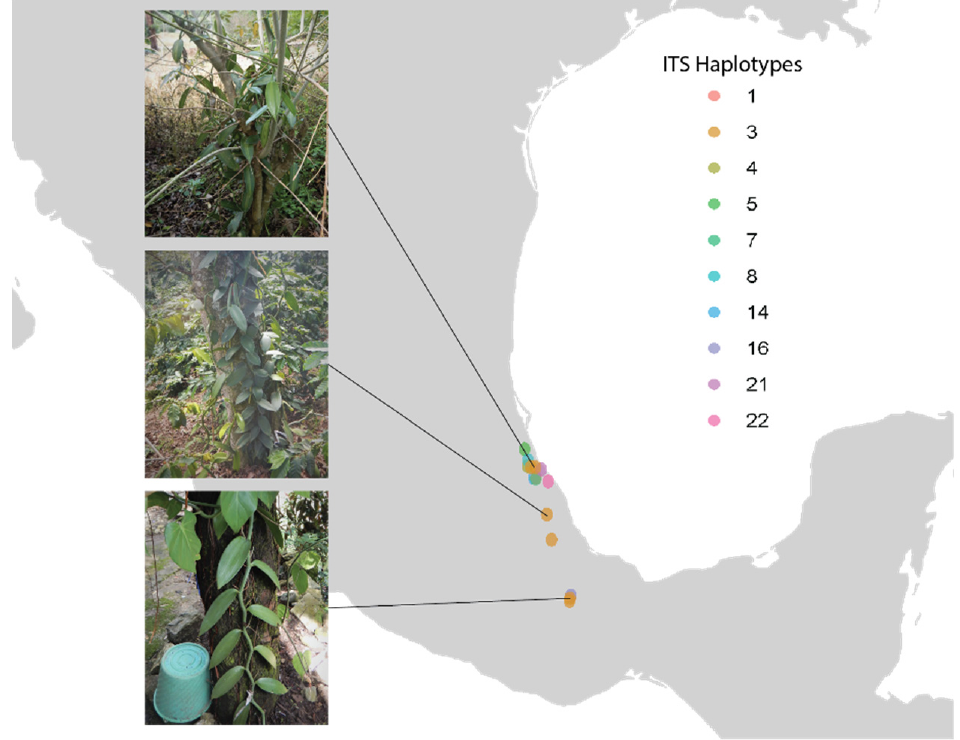
Figure 2. Map of sampling locations in Mexico. Point colors show haplotype IDs of samples as inferred by Ellestad et al. [19]. From top to bottom, photos show samples MEX41, MEX59, and MEX67. Table 1. Attributes and identifiers of generated genomic data used in this study. Raw genome cov- erage was calculated based on the 1-C reference genome size (736,752,966 bp) from the BioProject PRJNA633886 published in Hasing et al. [20].